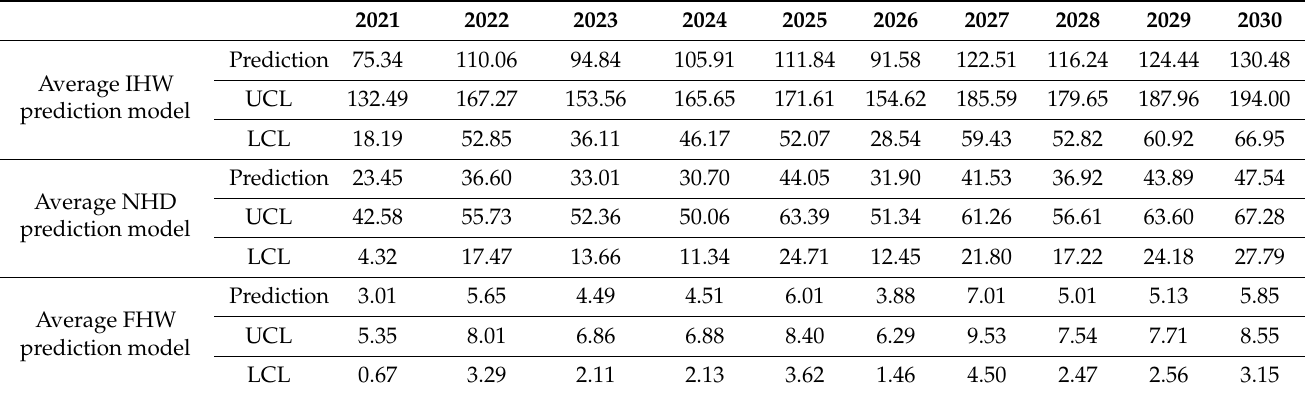
Figure 5. Fitted forecast graph of Chongqing’s high-temperature heat waves; ( a ) FHW fitted predic- tion graph; ( b ) NHD fitted prediction graph; ( c ) IHW fitted prediction graph. Table 2. ARIMA model prediction table.